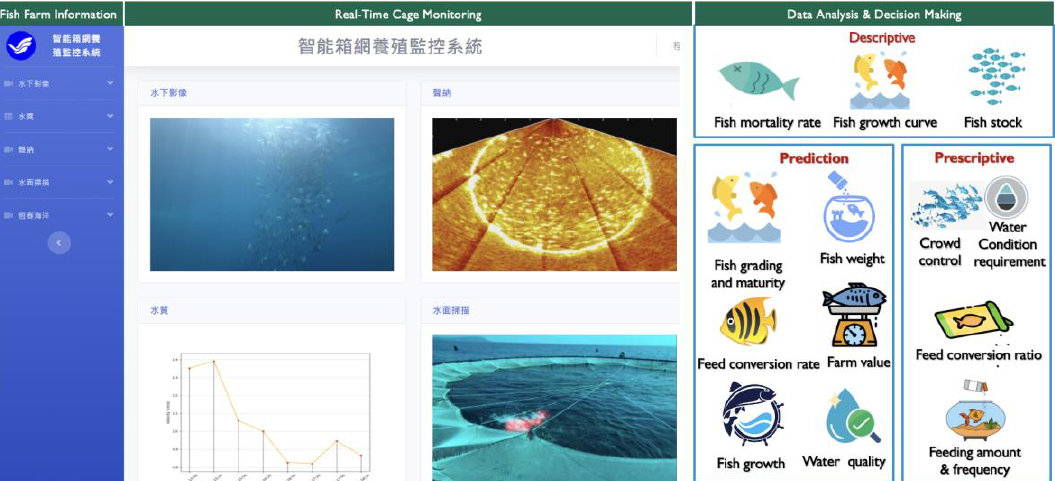
Figure 7. The web-based user interface for fish farm managers offering intelligent fish farming is based on our AIoT prototype system [8]. The Chinese titles “ 箱網養殖監控系統 ,” “ 水下影像 ,” “ 聲納 ,” “ 水質 ,” “ 水面掃描 ,” and “ 恆春海洋 ” are “Aquaculture cage monitoring system,” “Underwater image,” “Sonar image,” “Water quality,” “Water surface scanning”, and “Ever Spring Marine Co., Ltd.”.